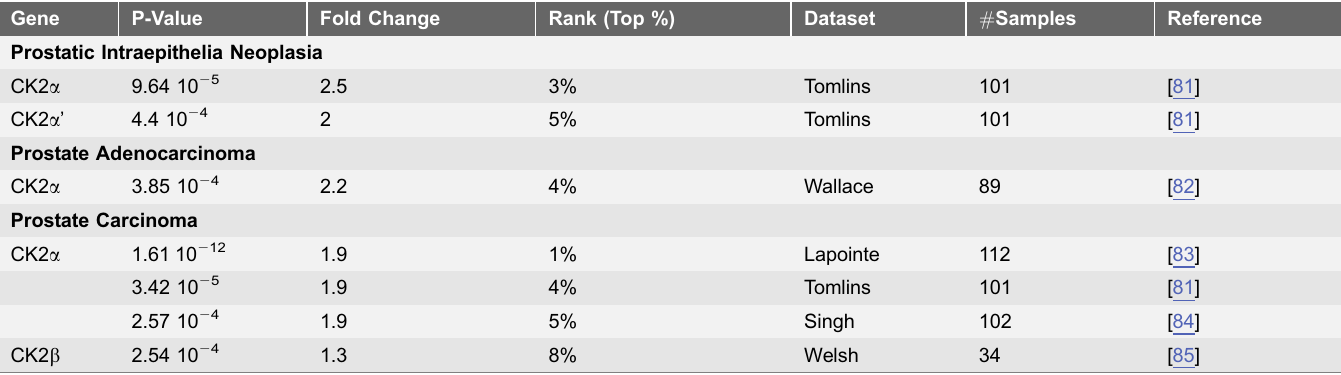
Table 6. Changes in CK2 gene expression in prostate